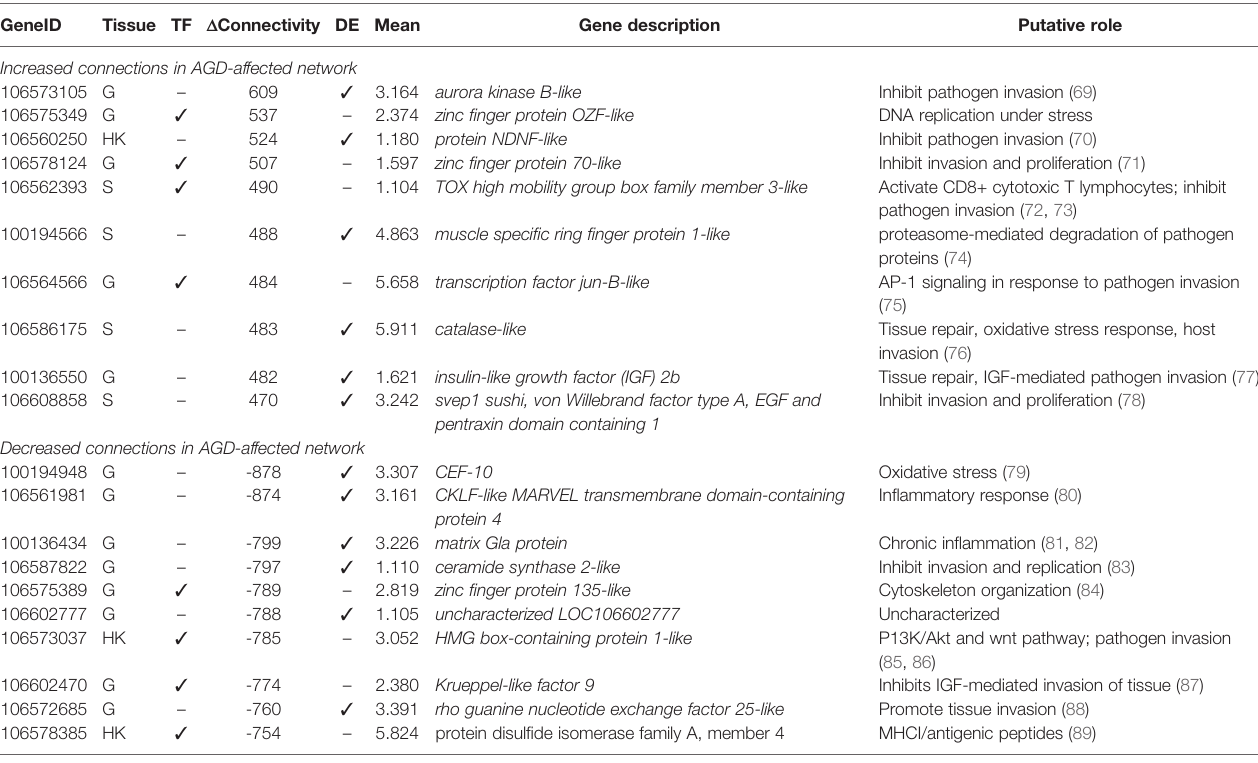
TABLE 2 | Top 20 differentially connected genes associated with amoebic gill disease (AGD) pathology in Atlantic salmon. Data for tissue of maximum expression, differential connectivity between naïve and AGD disease states, and mean expression are shown. GeneID Tissue TF D Connectivity DE Mean Gene description